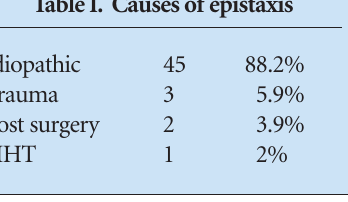
Table I. Causes of epistaxis